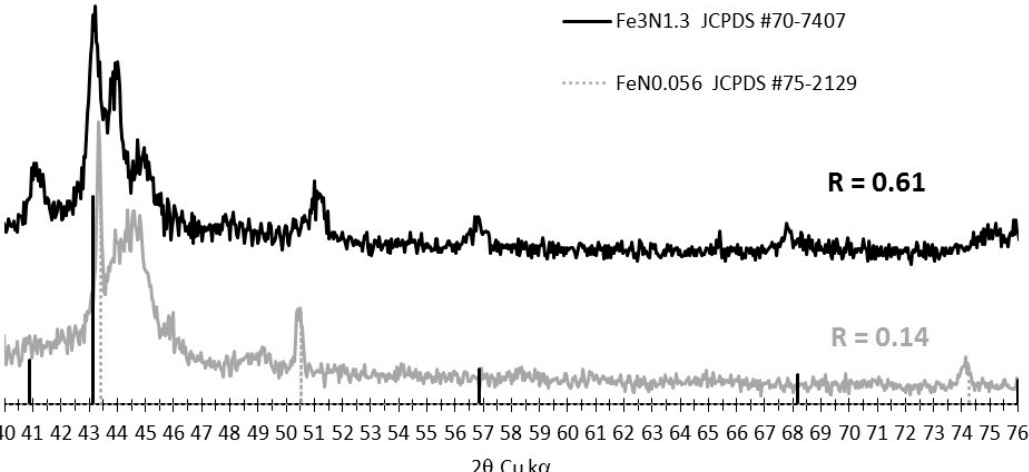
Figure 10. XRD pattern of sample obtained from LPM-1 after acid leaching for R = 0.14 and 0.61.